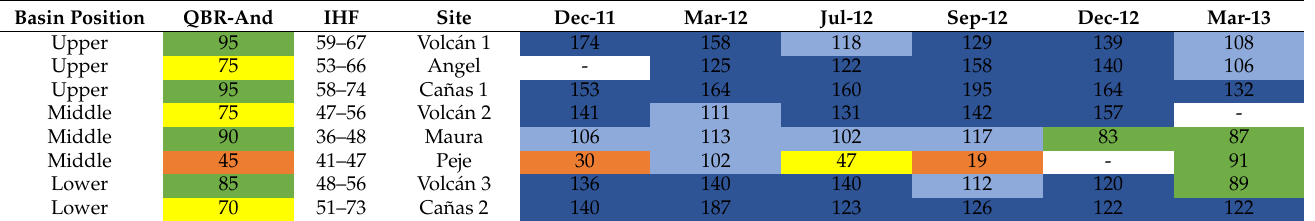
Table 1. Ecological quality index values (QBR-And, IHF (min–max), and BMWP-CR) calculated in 8 sites from the Volc á n River watershed, period